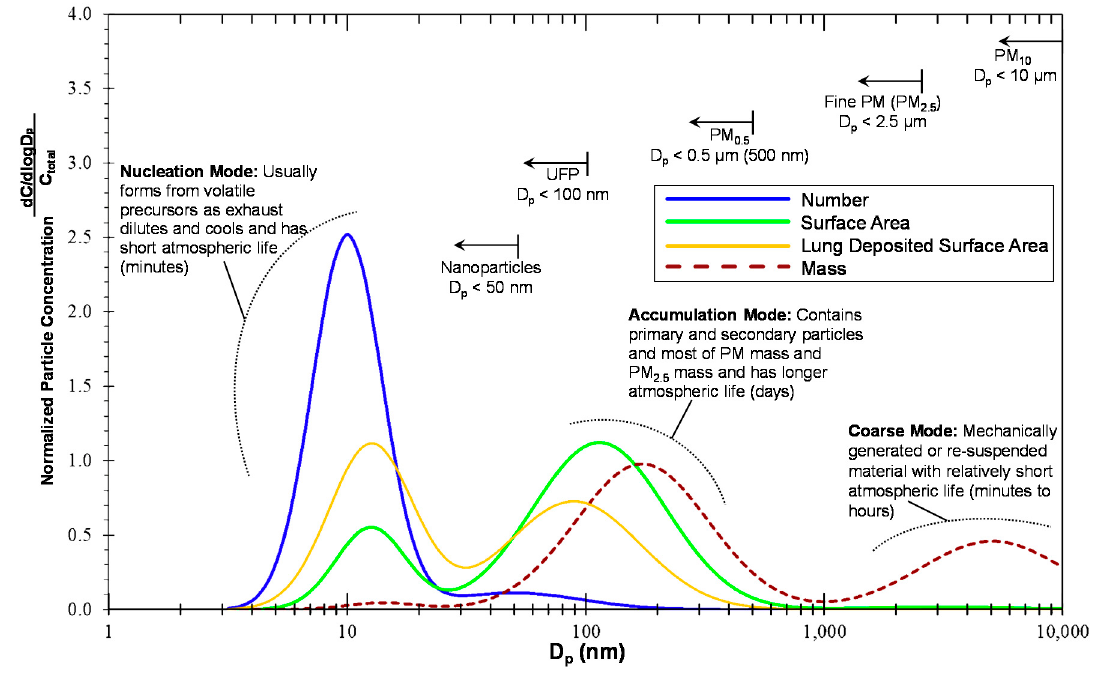
Figure 1. Tri-modal particle size distributions using different particle metrics (number, surface area, lung deposited surface area, and mass). For this figure, D p is the particle diameter, UFP are ultrafine particles, and PM stands for particulate matter.